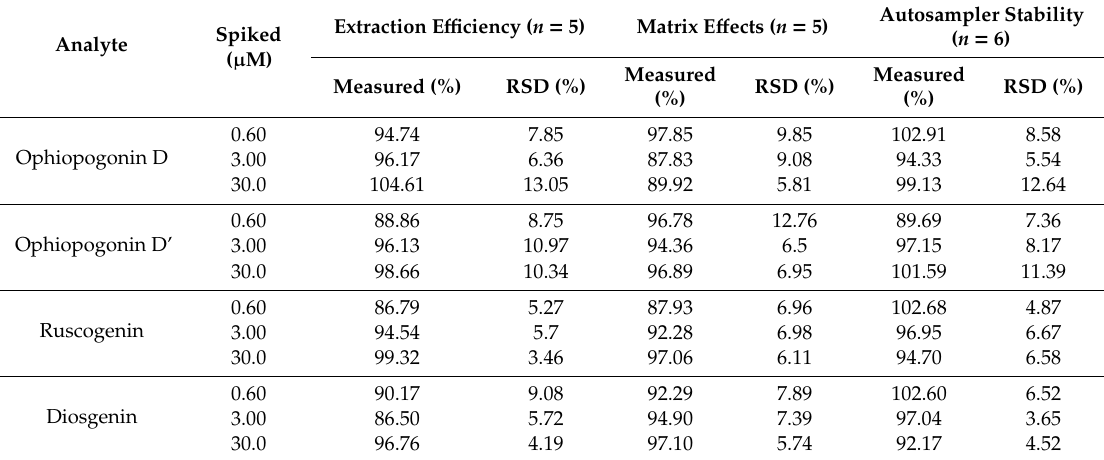
Table 4. Extraction e ffi ciency, matrix e ff ect and stability for UPLC-MS / MS assay of ophiopogonins in fermented broth of human gut